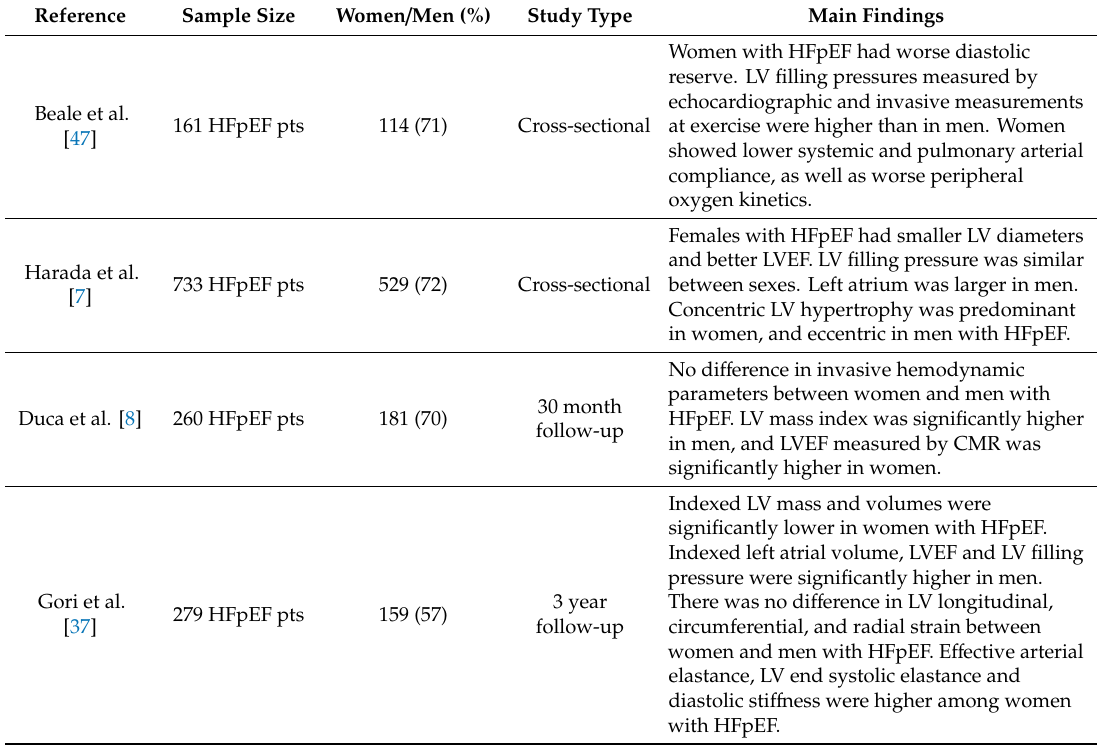
Sex-specific di ff erences in hemodynamic changes and cardiovascular remodeling in HFpEF